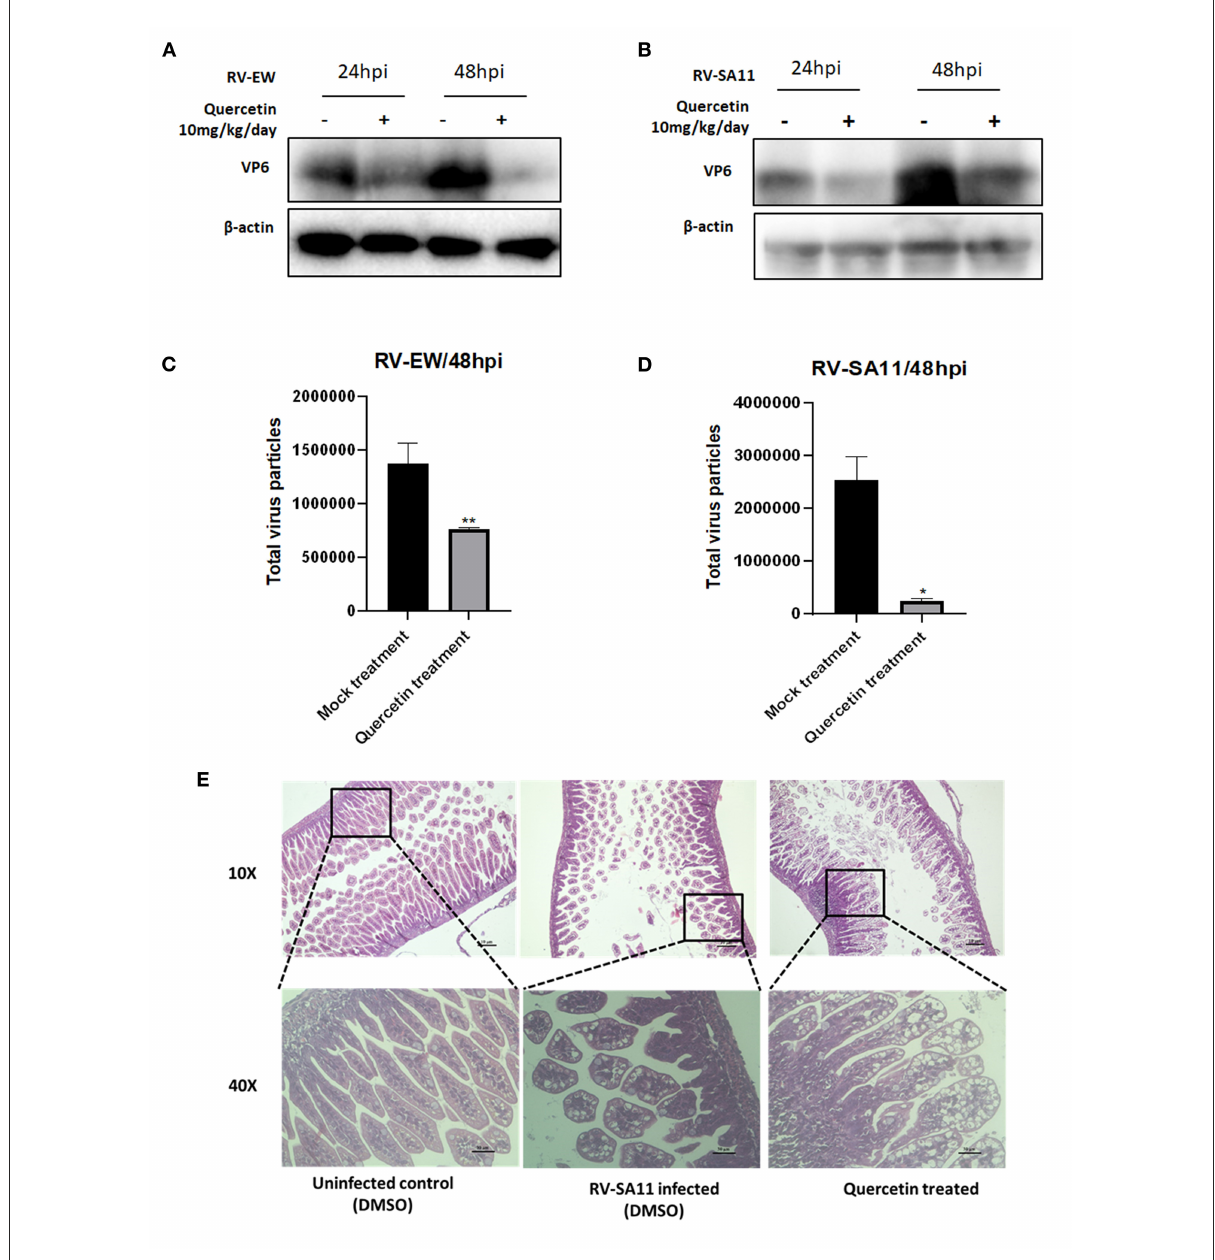
FIGURE5 Quercetin hinders rotavirus infection in mice model. (A,B) Expressions of VP6 and β -actin proteins were assessed by Western blot performed from the small intestinal tissue of 4-day-old suckling mice infected with (A) rotavirus murine strain Ew and (B) rotavirus simian strain SA11 followed by quercetin treatment after 24 and 48h. (C,D) Stool samples were collected from suckling mice infected with RV and treated either with DMSO or quercetin for 48h. Total virus particles were quantified afterward. Each bar represented mean ± SD of three